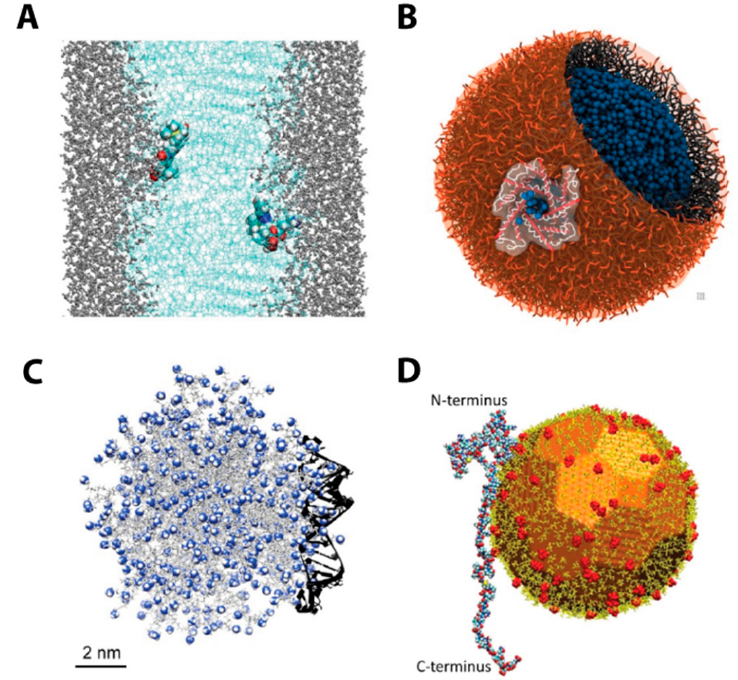
Figure 2. ( A ) Permeation of silatecan camptothecin drug analogue and a protonated 20( S )-4-aminobutyrate substituted prodrug in a hydrated dimyristoylphosphatidylcholine (DMPC) bilayer. Water molecules are represented as silver CPK, bilayer is represented as light blue lines and drugs are shown as VdW spheres. Reproduced with permission from Elsevier [155]. ( B ) Lipid vesicle containing a mechano-sensitive protein channel simulated with coarse-grain MARTINI force field. Water is represented as blue beads. Reproduced with permission from Royal Society of Chemistry [158]. ( C ) Binding between G7 PAMAM dendrimer and siRNA fragment; siRNA is represented as dark solid ribbons, while charged primary amine groups are represented as blue/white spheres. Reproduced with permission from Elsevier [150]. ( D ) Interaction between α -synuclein with 12 nm gold nanoparticle functionalized with partially ionized citrate ligands (charged moieties are shown as red spheres). Reproduced with permission from Wiley [161].